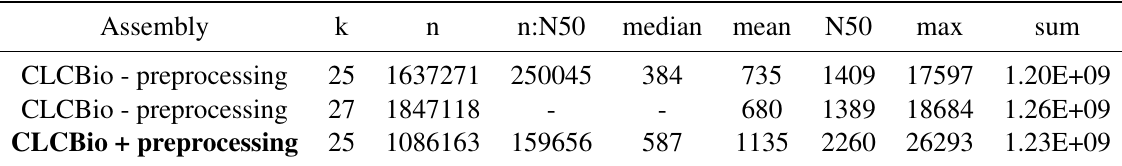
Table 2: List of Carp genome assemblies produced by the CLCBio assembler using different